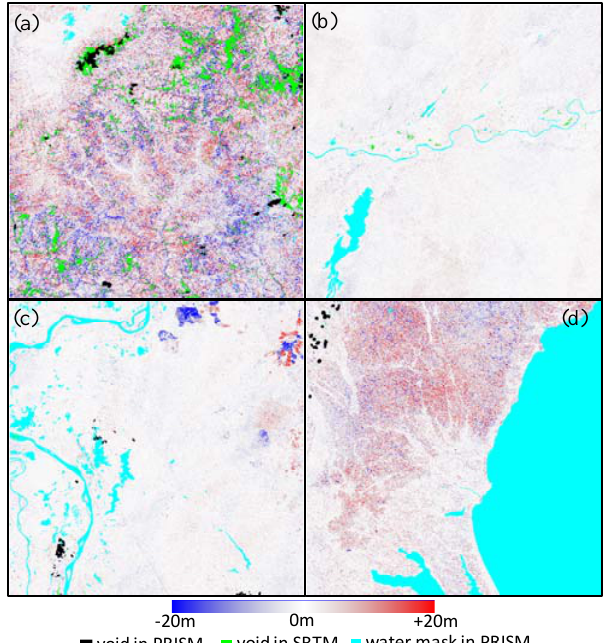
Figure 8. Height difference images between DSM tiles